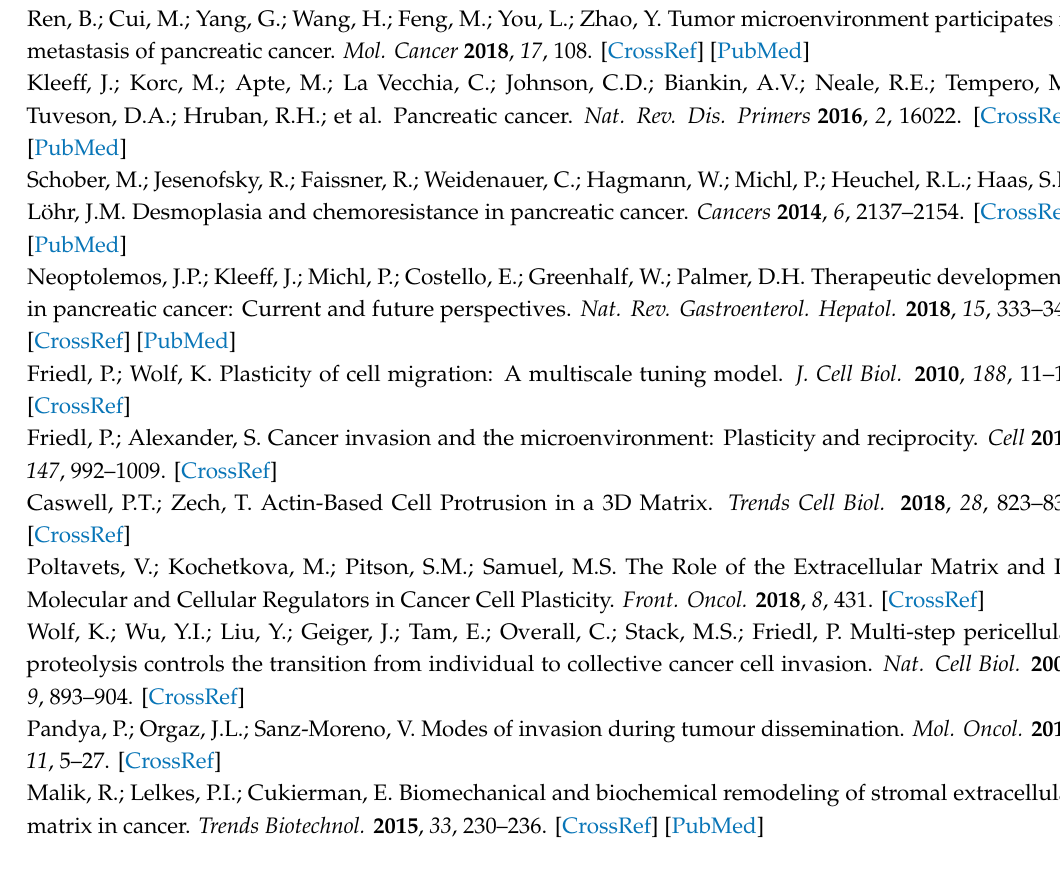
Figure S1: Expression of α -SMA and migration of PSCs when co-cultured with or without tumor spheroids (TSs). No significant di ff erence in the level of α -SMA ( A ) and number of cells migrated out of collagen channels ( B ) under TSs co-culture conditions. Cells were grown for 5 days in collagen-supported microchannel chips. Scale bar: 100 µ m, Figure S2: Expression of MT1-MMP in PANC-1 cells migrating with invadopodia. Cells were cultured in a 3D collagen matrix for 5 days and immunostaining was performed without a permeabilization step. Scale bar: 20 µ m, Figure S3: Formation of tumor spheroids (TSs) of MIA PaCa-2 and Capan-1 cells and expression of EMT markers when co-cultured with or without PSCs. ( A ) Morphology of membrane protrusion shown by actin-based podia (white arrow). ( B ) Expression of EMT marker proteins E-cadherin and vimentin. Cells were grown for 5 days in collagen-supported microchannel chips and stained with F-actin, E-cadherin, vimentin and DAPI. Scale bar: 50 µ m. * p < 0.05, Figure S4: ( A ) Expression of fibronectin with or without serum in a cell-free collagen matrix. ( B ) Expression of fibronectin in regions close to the TSs of PANC-1 and BxPC-3 cells. Immunostaining was performed at day 5 of culture. Scale bar: 50 µ m ( A , B